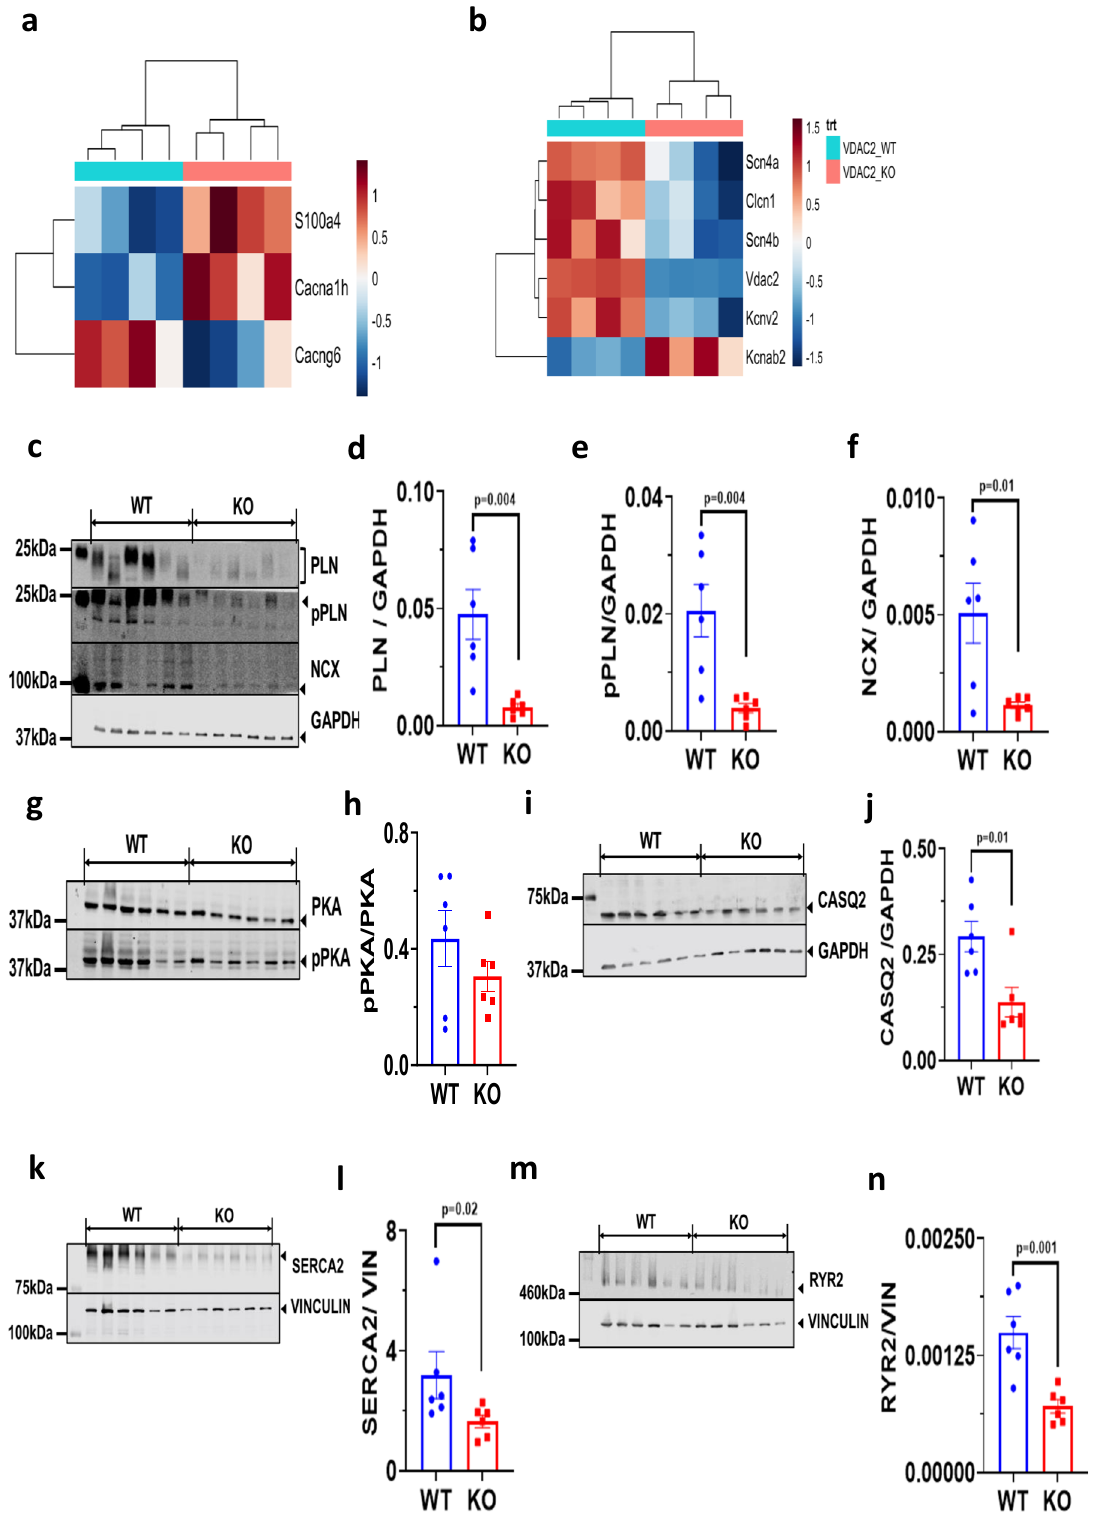
normal cardiac function (Fig. 2b). Proteins involved in ECC such as RYR2, SERCA2, NCX1, total and phosphorylated phospho- lamban (PLN), and calsequestrin (CASQ2, the SR calcium- binding protein) were signi fi cantly decreased in the KO (Fig. 2c – n). Collectively, these results suggest that loss of VDAC2 leads to abnormalities in cellular calcium signaling